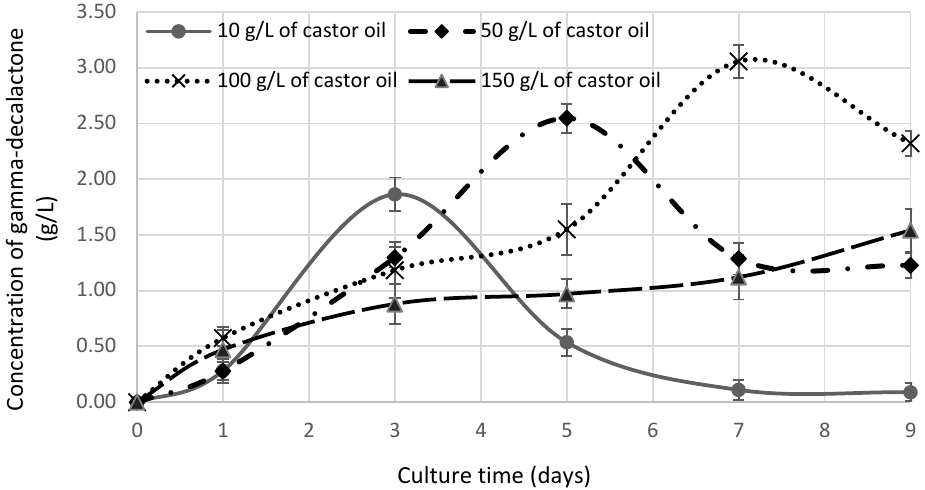
Figure 1. Effect of castor oil concentration in the medium on the amount of synthesized GDL.